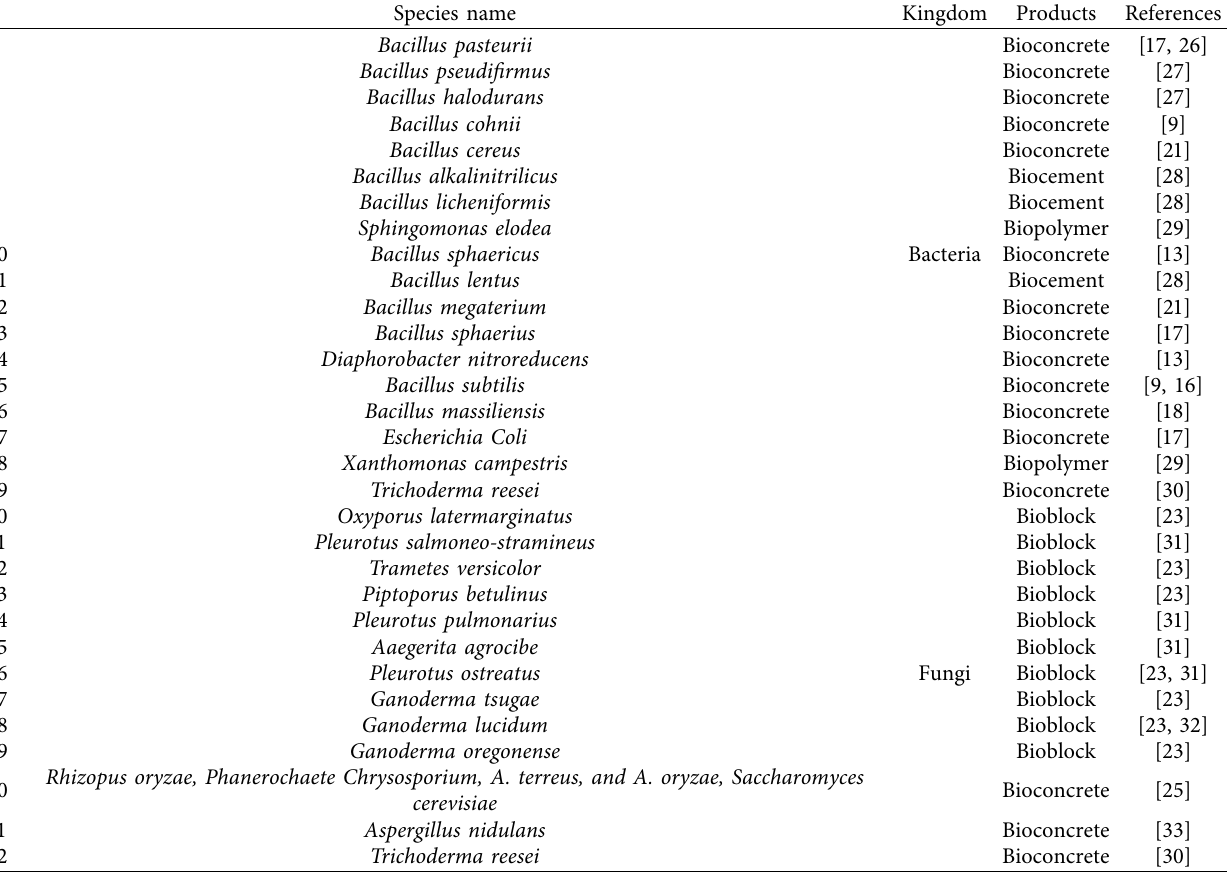
Table 1: Specific microorganisms applied in the production of construction materials.